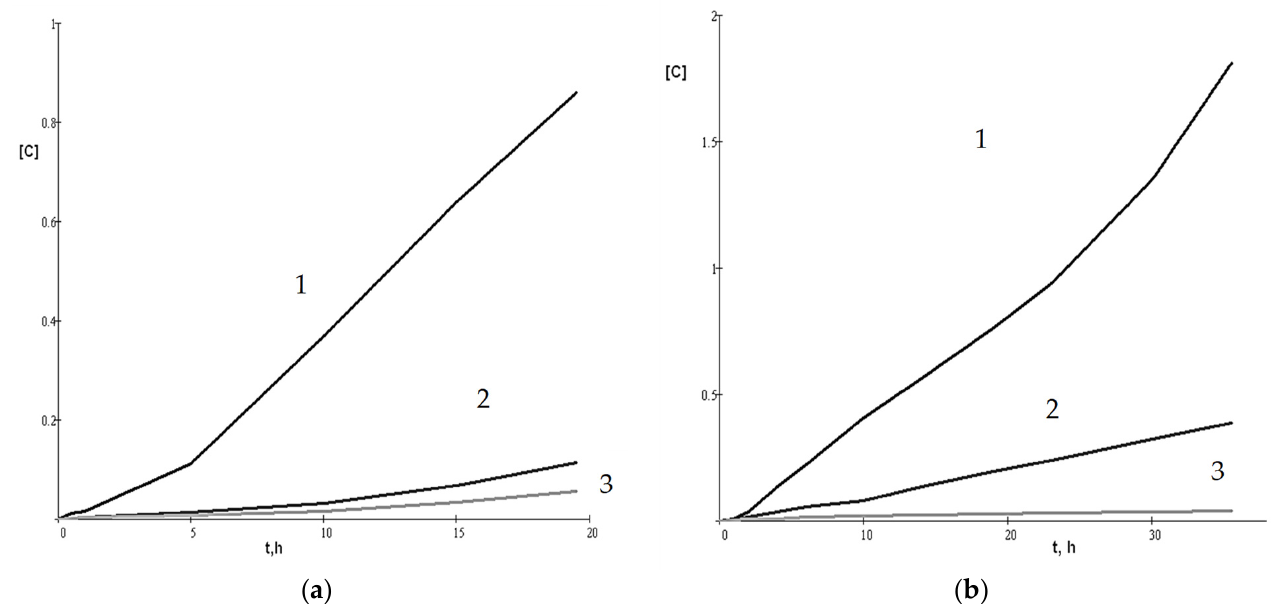
Figure 1. Kinetics of the accumulation of PEH (1), acetophenone AP (2), and methylphenylcarbinol MPC (3) ( a , b ) in the oxidation of ethylbenzene catalyzed by the triple systems {Ni(acac) 2 + HMPA + PhOH} ( a ), and {Ni(acac) 2 + NaSt + PhOH} ( b ). [Ni(acac) 2 ] = 3×10 − 3 mol/L, [HMPA] = 2×10 − 2 mol/L, [NaSt] = 3×10 − 3 mol/L, [PhOH] = 3×10 − 3 mol/L, 120 °C.